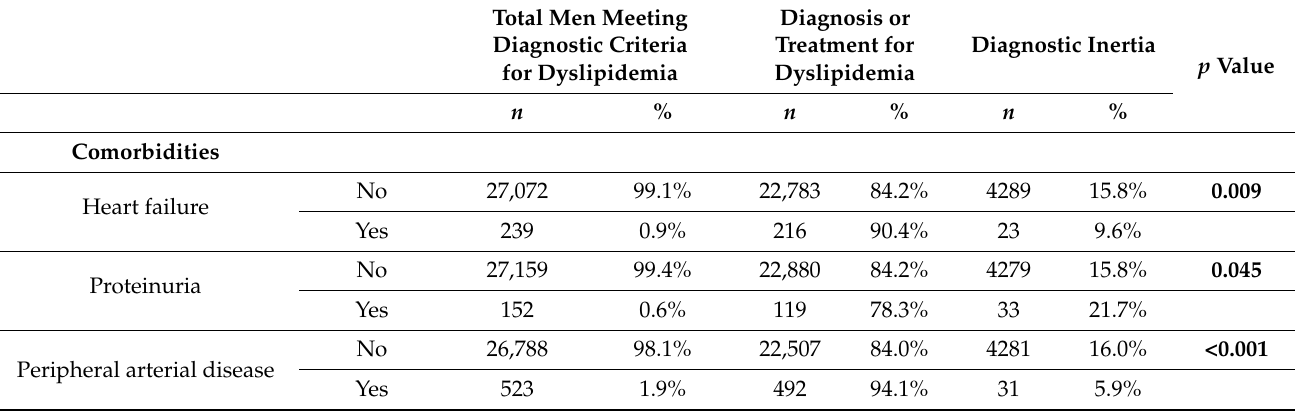
Table 2. Prevalence of diagnostic inertia in men according to comorbidities and treatments. Total Men Meeting Diagnostic